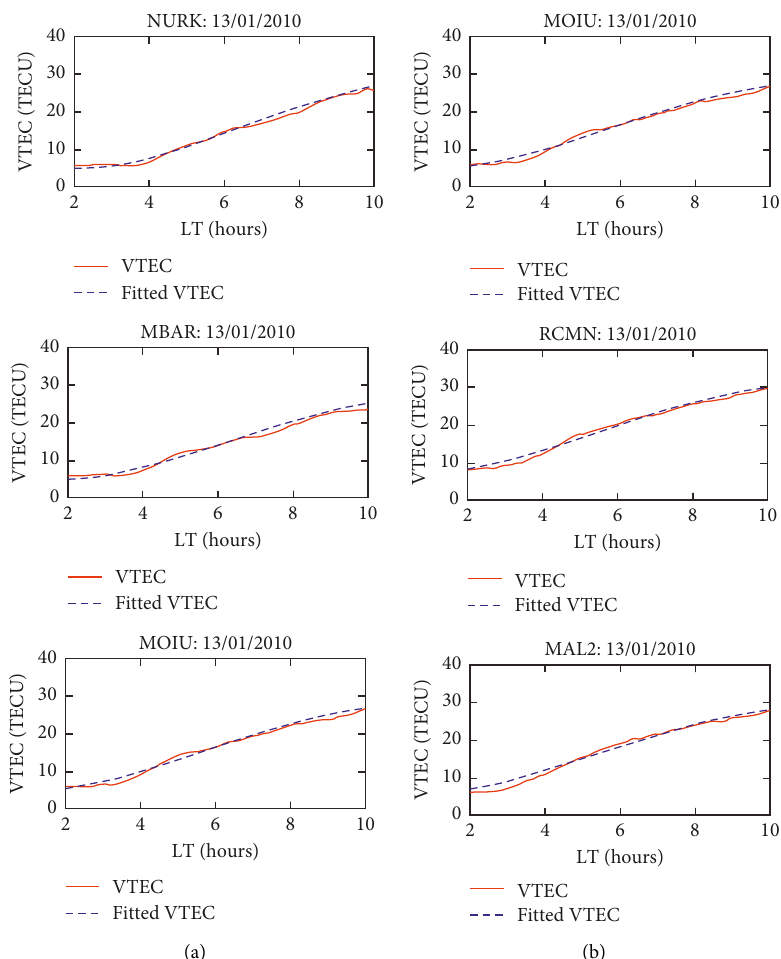
Figure 7: VTEC and fitted VTEC against local time (LT) across (a) NURK-MBAR-MOIU and (b) MOIU-RCMN-MAL2 GPS array on 13 th January